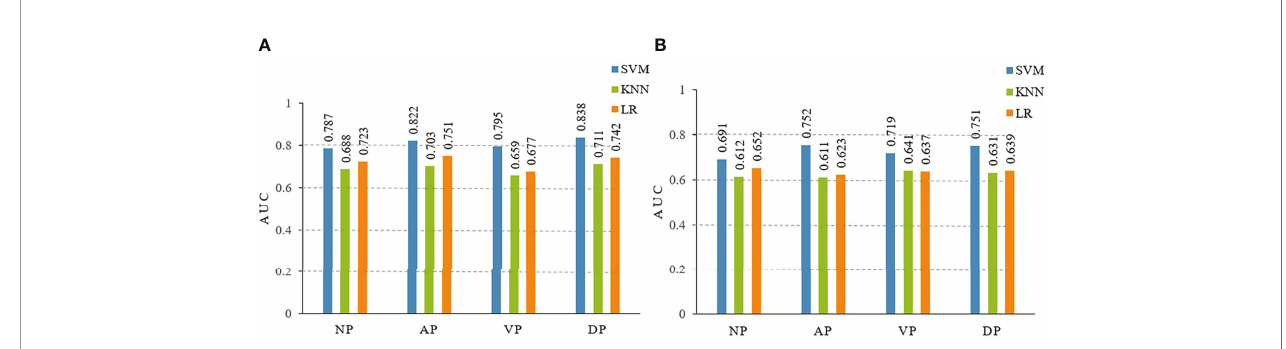
FIGURE 4 | The area under the curves (AUCs) of receiver operating characteristics (ROC) curve analysis for three models of LR, KNN, SVM in the training (A) and testing (B) cohorts. LR, logistic regression; KNN, K-nearest neighbor; SVM, support vector machine. NP, non-enhanced phase; AP, arterial phase; VP, venous phase; DP,